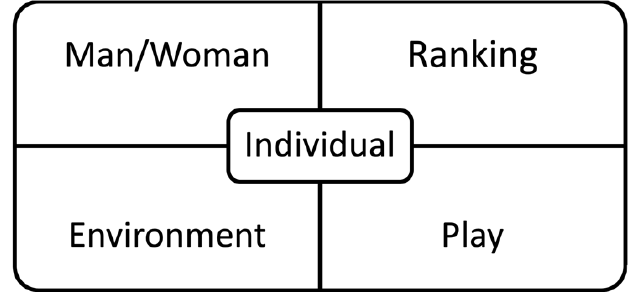
Figure 4. Five-Roles model of personality